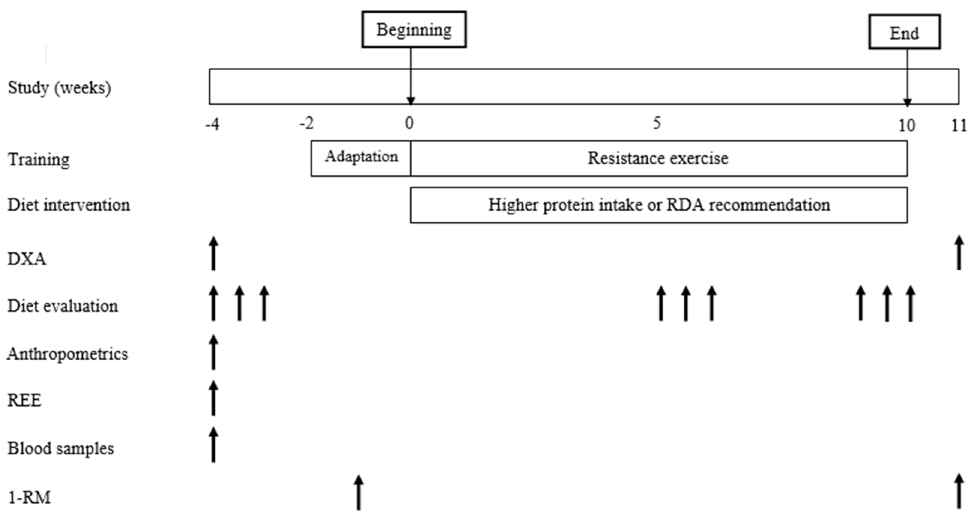
Figure 2. Schematic overview diagram of the study protocol.